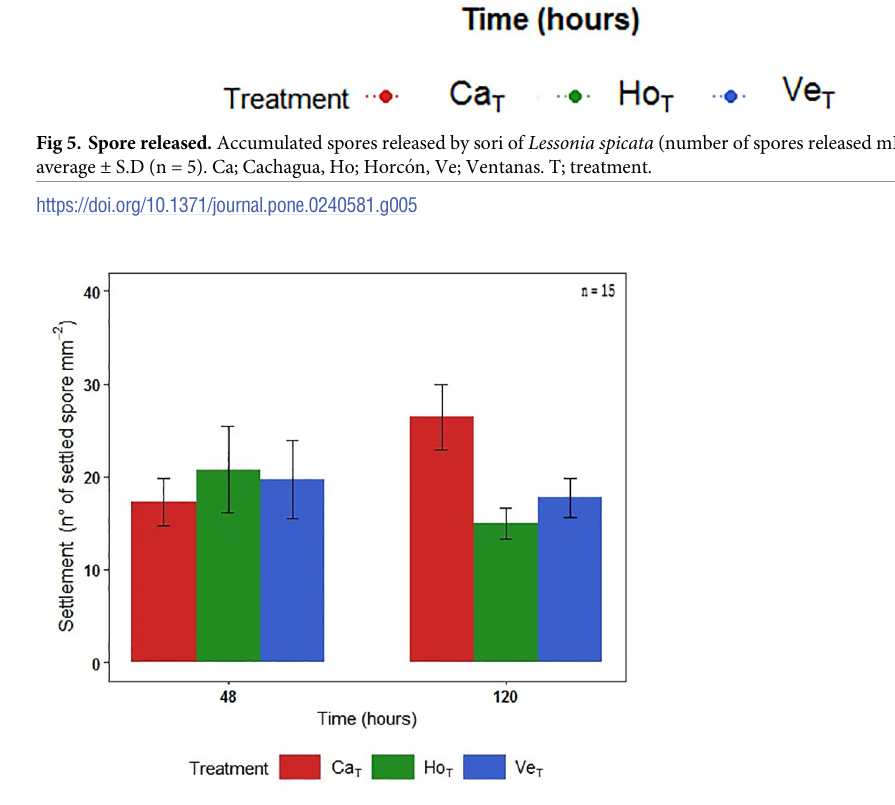
PLOS ONE | https://doi.org/10.1371/journal.pone.0240581 October 15,